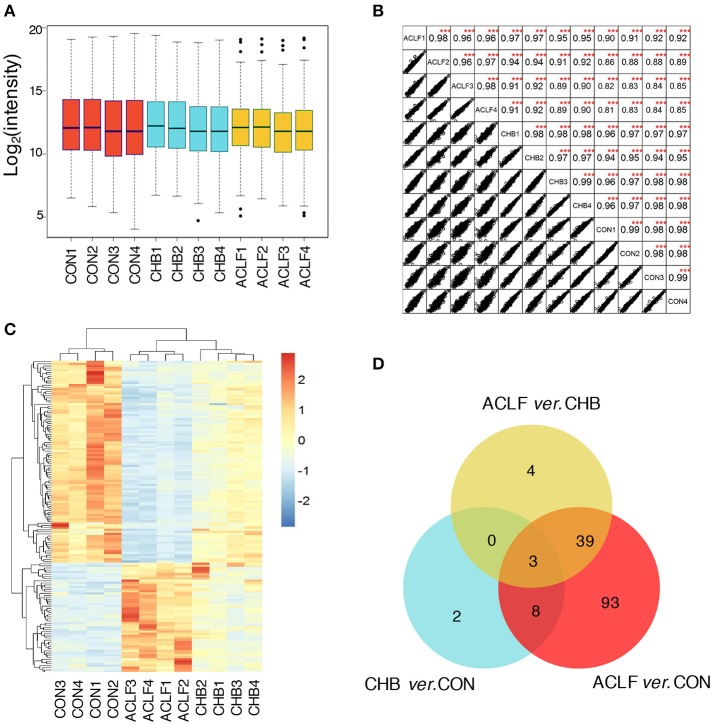
Identification of total proteins and differentially expressed proteins. (A) Box plots of log2 protein intensity average for each sample. (B) Correlation analysis between each two samples. Rows and columns represent samples, and each square shows the correlation coefficients between two samples. ***p < 0.001 comparing intensity of each two samples. (C) Heatmap of the significantly changed proteins. Rows represent proteins and columns represent different samples. Color of each cell represents expression change of proteins, red is increased and blue is decreased relative to control group. (D) Venn diagram shows the overlap of differential proteins between comparison of each two groups.